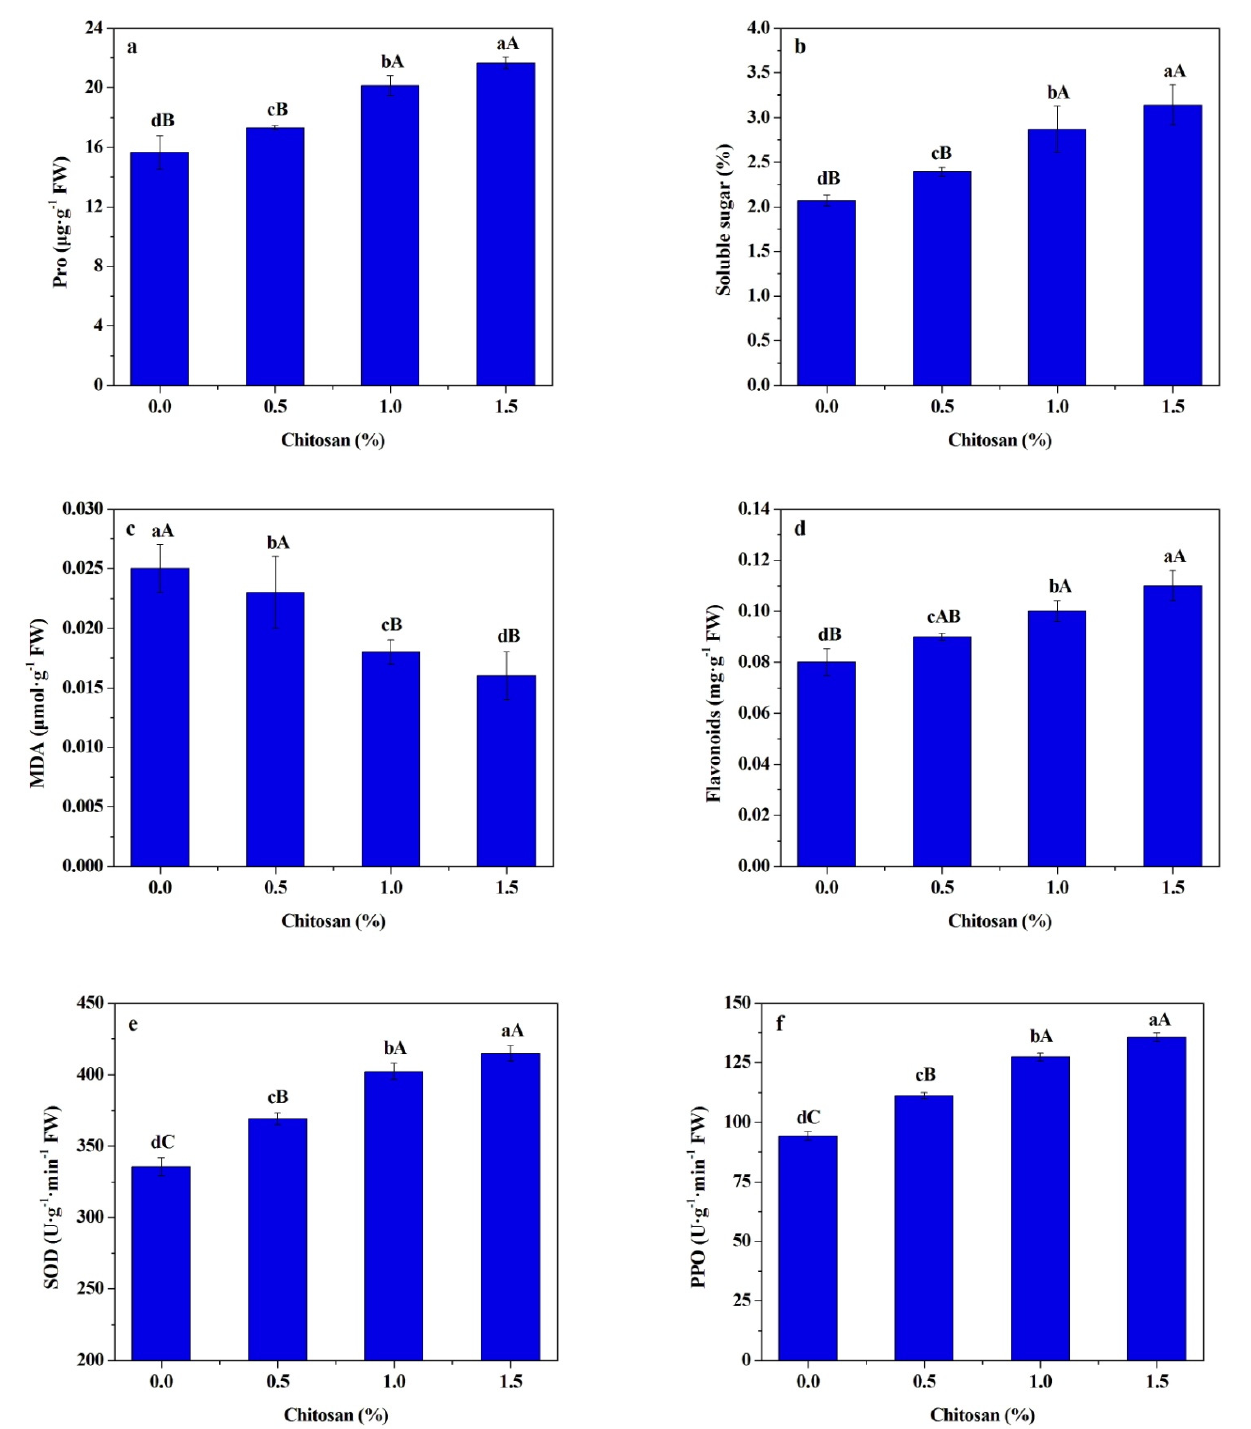
Figure 1. The effects of chitosan on the proline ( a ), soluble sugar ( b ), malonaldehyde ( c ), flavonoids ( d ), SOD activity ( e ), and PPO activity ( f ) of leaves in R. roxburghii . Values and error bars indicate the mean and SD of three replicates, respectively. Different small and capital letters indicate significant differences at 5% level ( p < 0.05) and 1% level ( p < 0.01), respectively. 3.3. Effects of Chitosan on Photosynthetic Rate and Chlorophyll Content of R. roxburghii Leaves